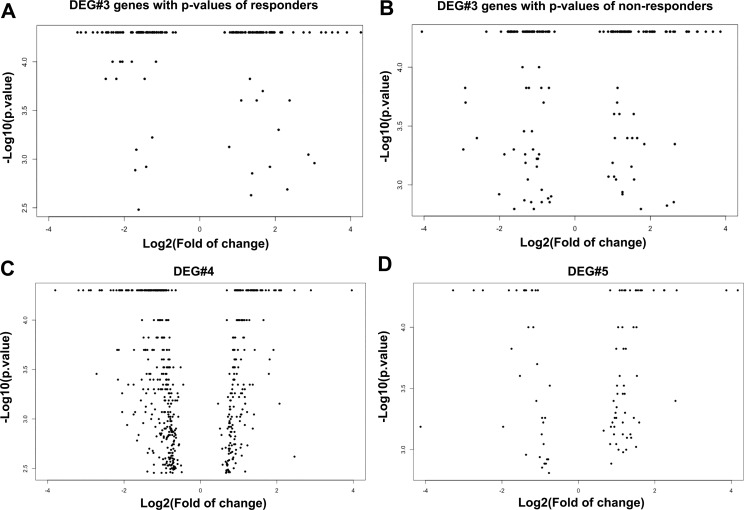
Volcano plot of DEGs 3–5.The fold of change (log2) and p value (-log10) of the genes in DEGs 3, 4, and 5 are shown in volcano plots. Since the genes in DEG#3 have two p values, one from responders and the other from non-responders (S3 Table), they are shown in two plots, (A) and (B), respectively. (C) DEG#4; (D) DEG#5.